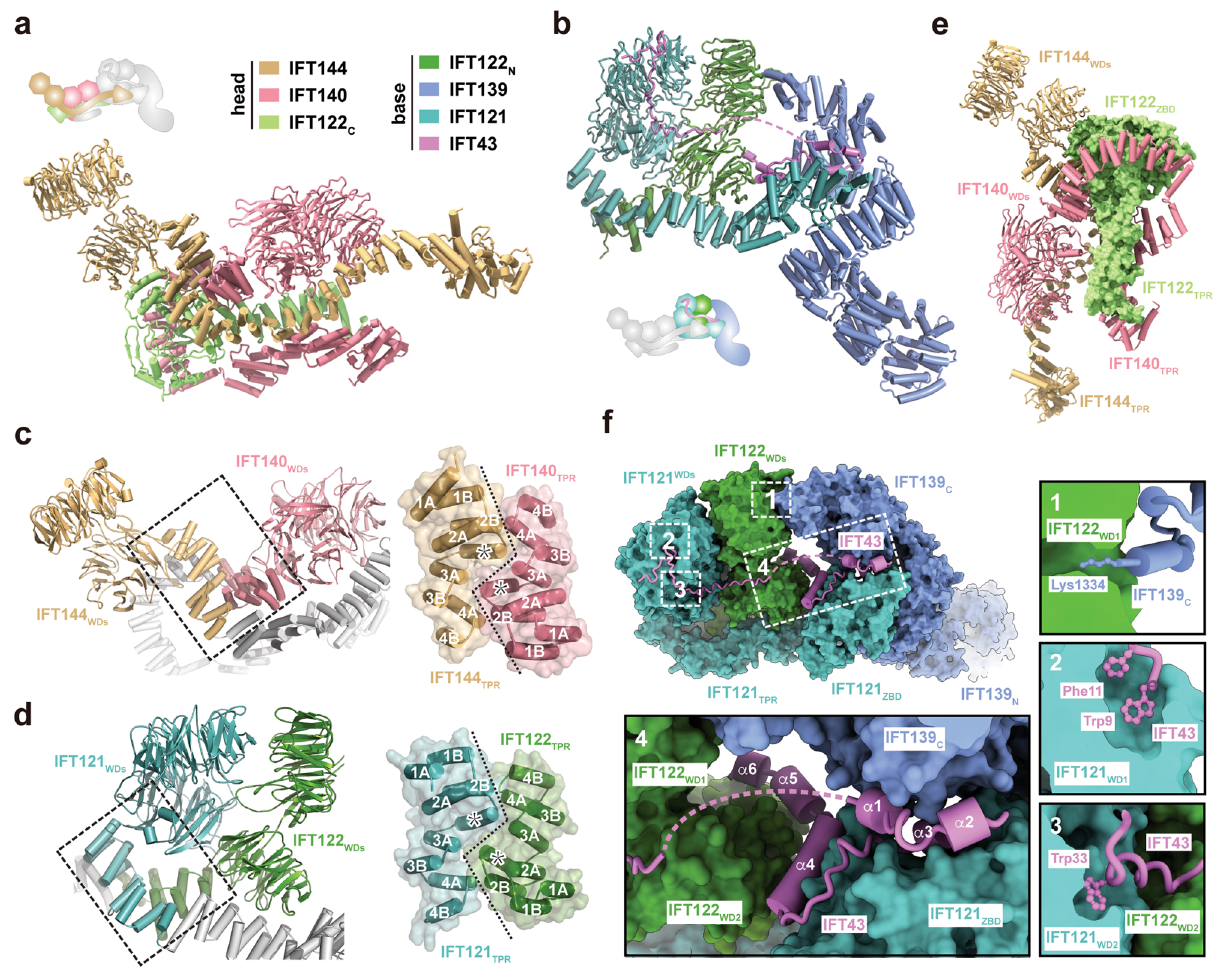
Fig.2|TheheadandbasemodulesofIFT-A. Atomicstructuresofthehead( a )and base ( b ) modules. The color scheme is shown. The cartoon indicates the relative position of the modules in the elongated state of IFT-A. The pseudo-two-fold symmetric IFT144-IFT140 ( c ) and IFT122-IFT121 heterodimers ( d ). The central TPR junctions formed by the fi rst four TPRs are highlighted in black dashed boxes, whichareenlargedontheright.TheTPRsarenumberedandtheinserted α -helixin